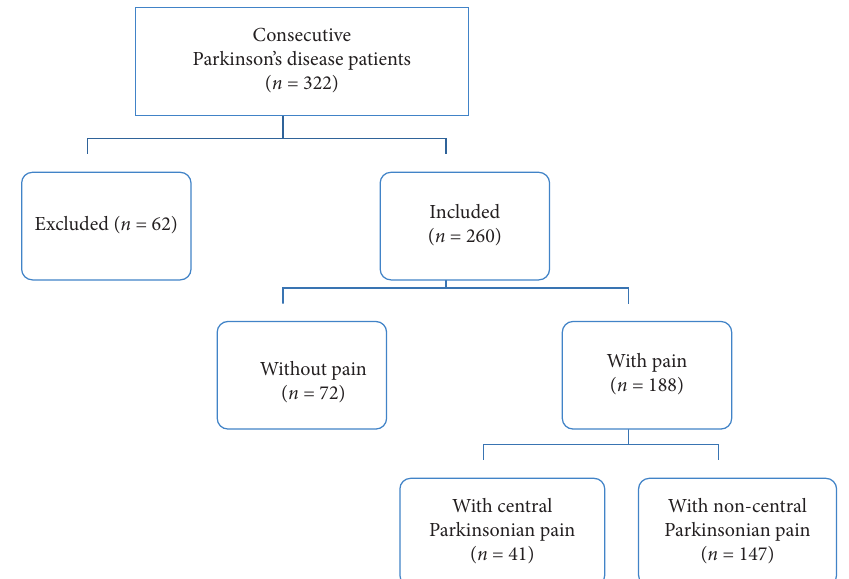
Figure 1: Flowchart of the study